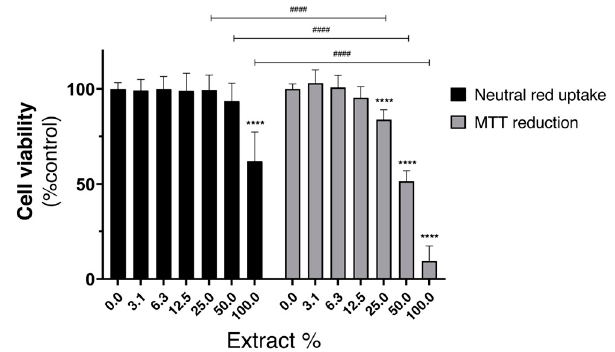
Figure 11. Cytotoxicity of AzoIz.Pip-dyed silk samples extracts (0–100 %) evaluated in HaCat cells by the MTT reduction and NR uptake assay, 24 h after exposure. Results are expressed as Mean + SD from 4 independent experiences, performed in triplicate. Statistical comparisons were made using Two-way ANOVA followed by the Sidak’s multiple comparisons test (**** p < 0.0001 vs. 0 %; #### p < 0.0001 for comparisons between cytotoxic assays, at each extract concentration).